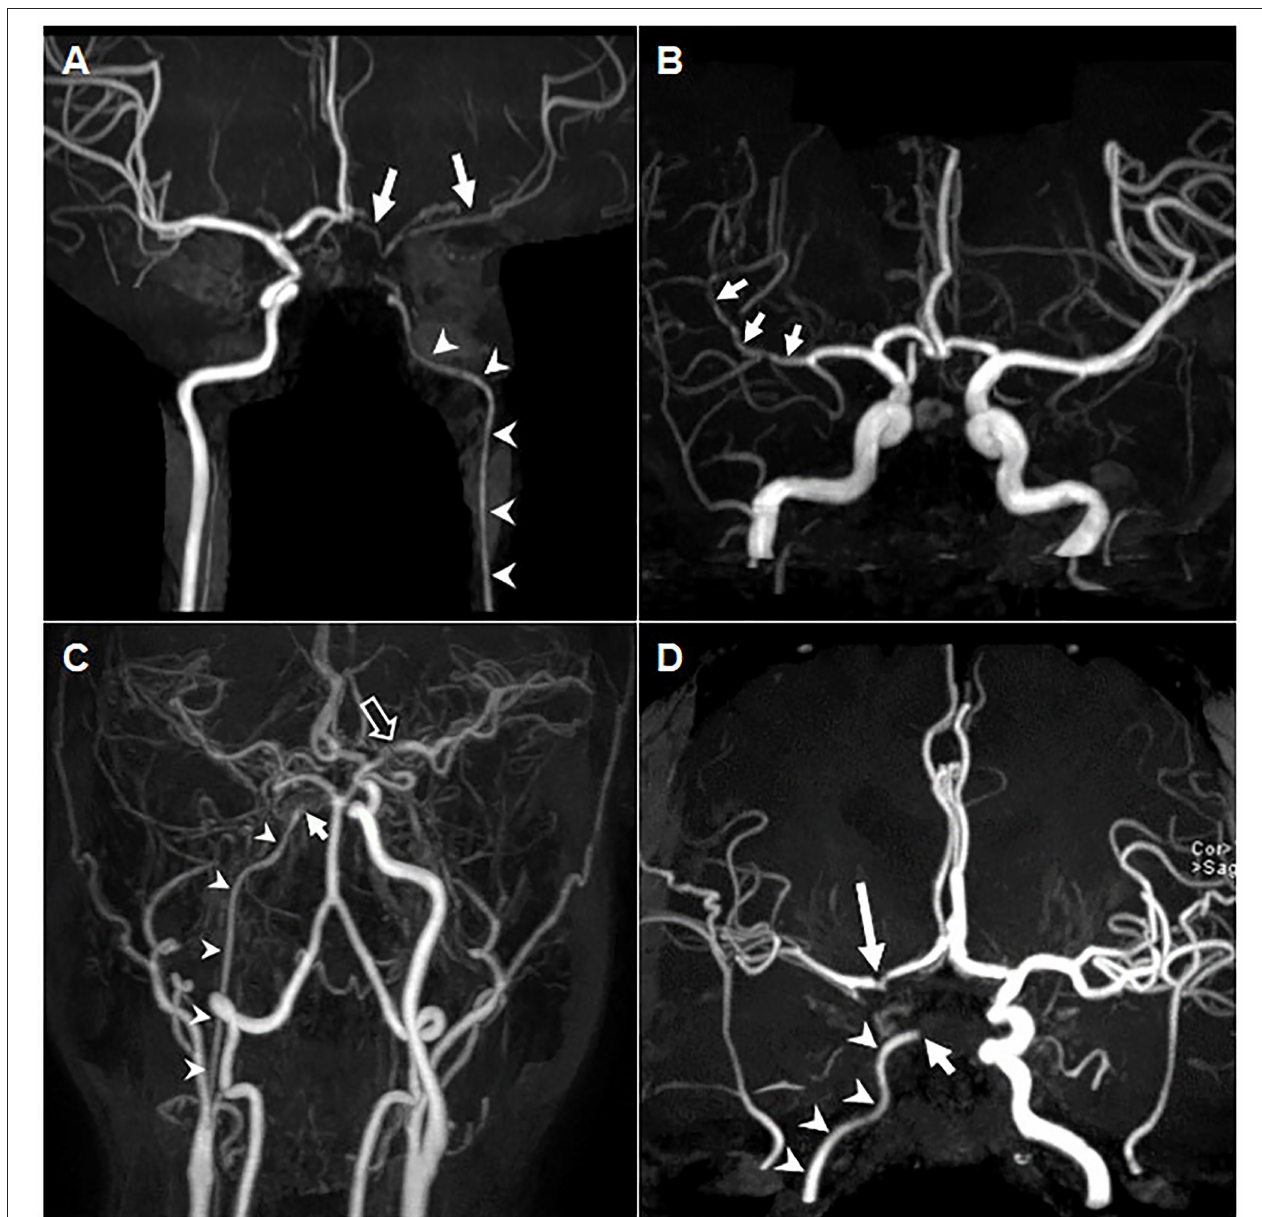
FIGURE 1 | Long-segmental diffuse luminal stenosis of PV-aPL. (A) MRA of Patient 1, a 21-year-old woman with right arm weakness, showing a long-segmental diffuse stenosis of her left ICA (arrowhead), ACA and MCA (arrows). (B) Non-contrast MRA of Patient 2, a 45-year-old woman with left side weakness for 6h, showing diffuse stenosis in the M1 distal to M2 segments of the right MCA (arrows). (C) Contrast-enhanced MRA of Patient 3, a 43-year-old man with a chronic headache for 1 month, showing diffuse stenosis of the right ICA (arrowheads) with distal occlusion (arrow), along with focal stenosis of the left MCA proximal to segment M1 (hollow arrow). (D) Non-contrast MRA of Patient 4, a 42-year-old woman with a chronic headache for 5 years and recurrent cerebral infarctions showed occlusion at a cavernous segment of the right ICA (short arrow) and long-segmental narrowing at the proximal ICA (arrowheads), with additional focal stenosis in the right ICA terminus (long arrow). aPLs, antiphospholipid antibodies; ICA, internal carotid artery; MCA, middle cerebral artery; MRA, magnetic resonance angiography; PV, non-thrombotic proliferative vasculopathy.